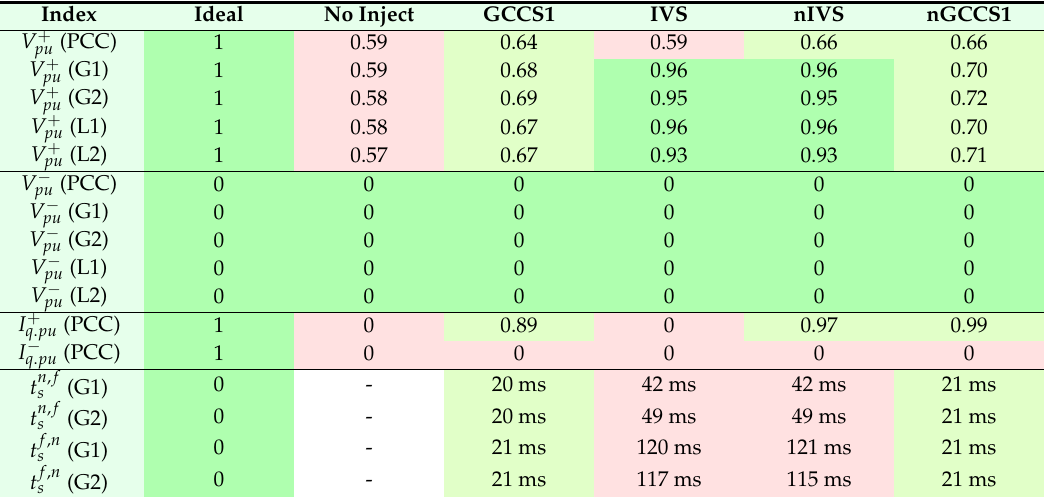
Table 6. Quality indexes measured for type III voltage